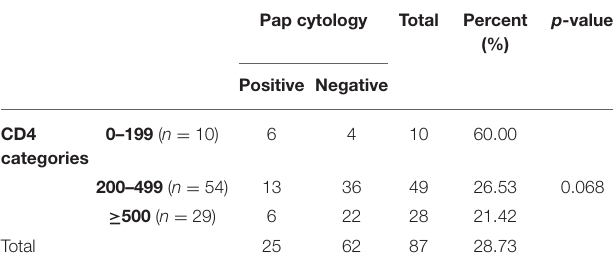
HSIL, high-grade squamous intraepithelial lesion; LSIL, low-grade squamous intraepithelial lesion; ASCUS, atypical squamous cells of undetermined significance; NILM, negative for intraepithelial malignancy or lesion; 0-VL, not detected/below level of detection. TABLE 3 | Frequency of Pap positivity in CD4 categories ( n =